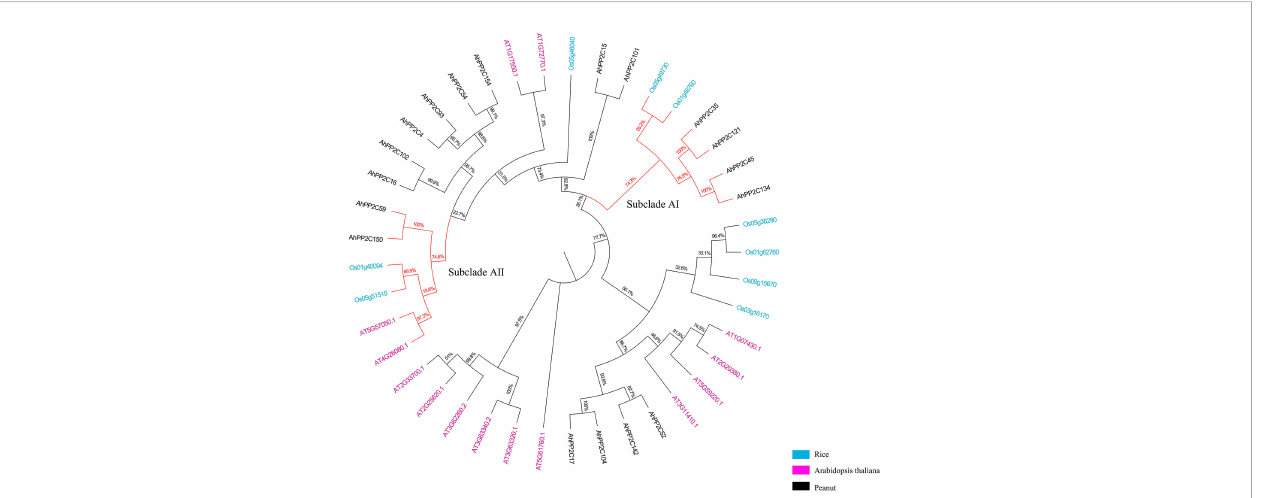
FIGURE 5 Phylogenetic tree of clade A AhPP2Cs , with salt tolerant genes from Arabidopsis and rice. The branches of subclades AI and AII are indicated in